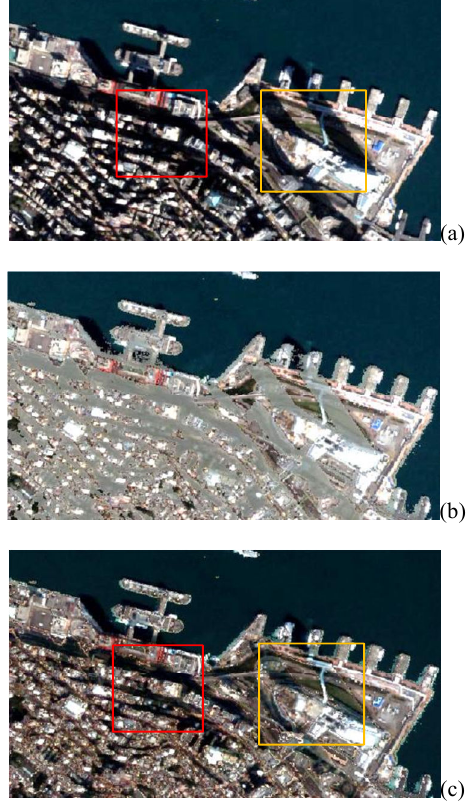
Figure 8. Central - a) Original image; b) By Gamma Correction; c) By Linear-Correlation Correction Compared the enhancement result, Gamma Correction (Figure